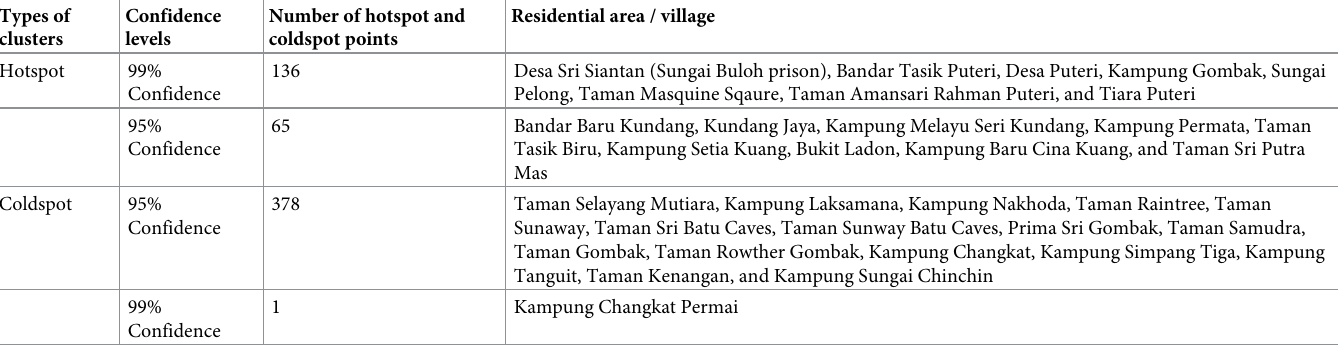
Table 2. Summary of hotspot and coldspot points of TB cases in Gombak, 2013 to 2017. Types of